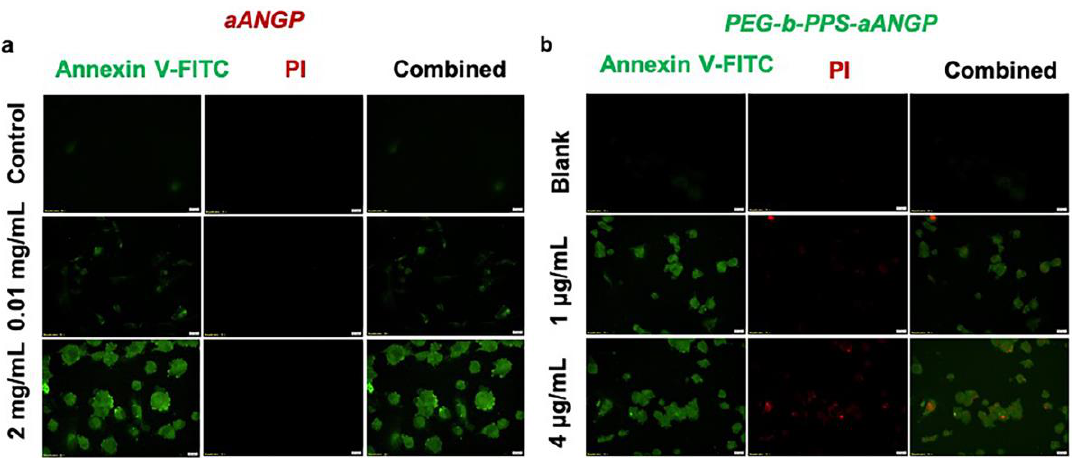
Figure 8. Confocal images of apoptosis induced by aANGP and aANGP-MCs: ( a ) Images obtained for aANGP and ( b ) aANGP-MCs. Green—Annexin V- FITC (apoptosis), red—PI (necrosis). Values were expressed as mean ± SD, n = 3. p < 0.005.